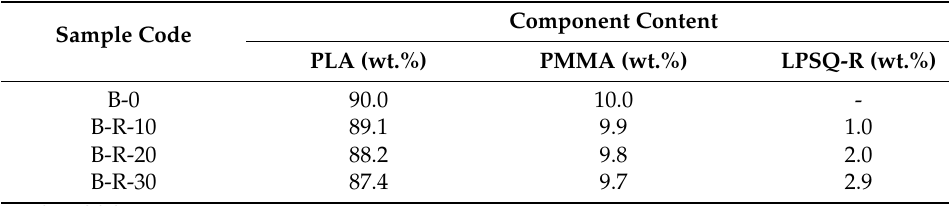
Table 1. Component contents in the prepared